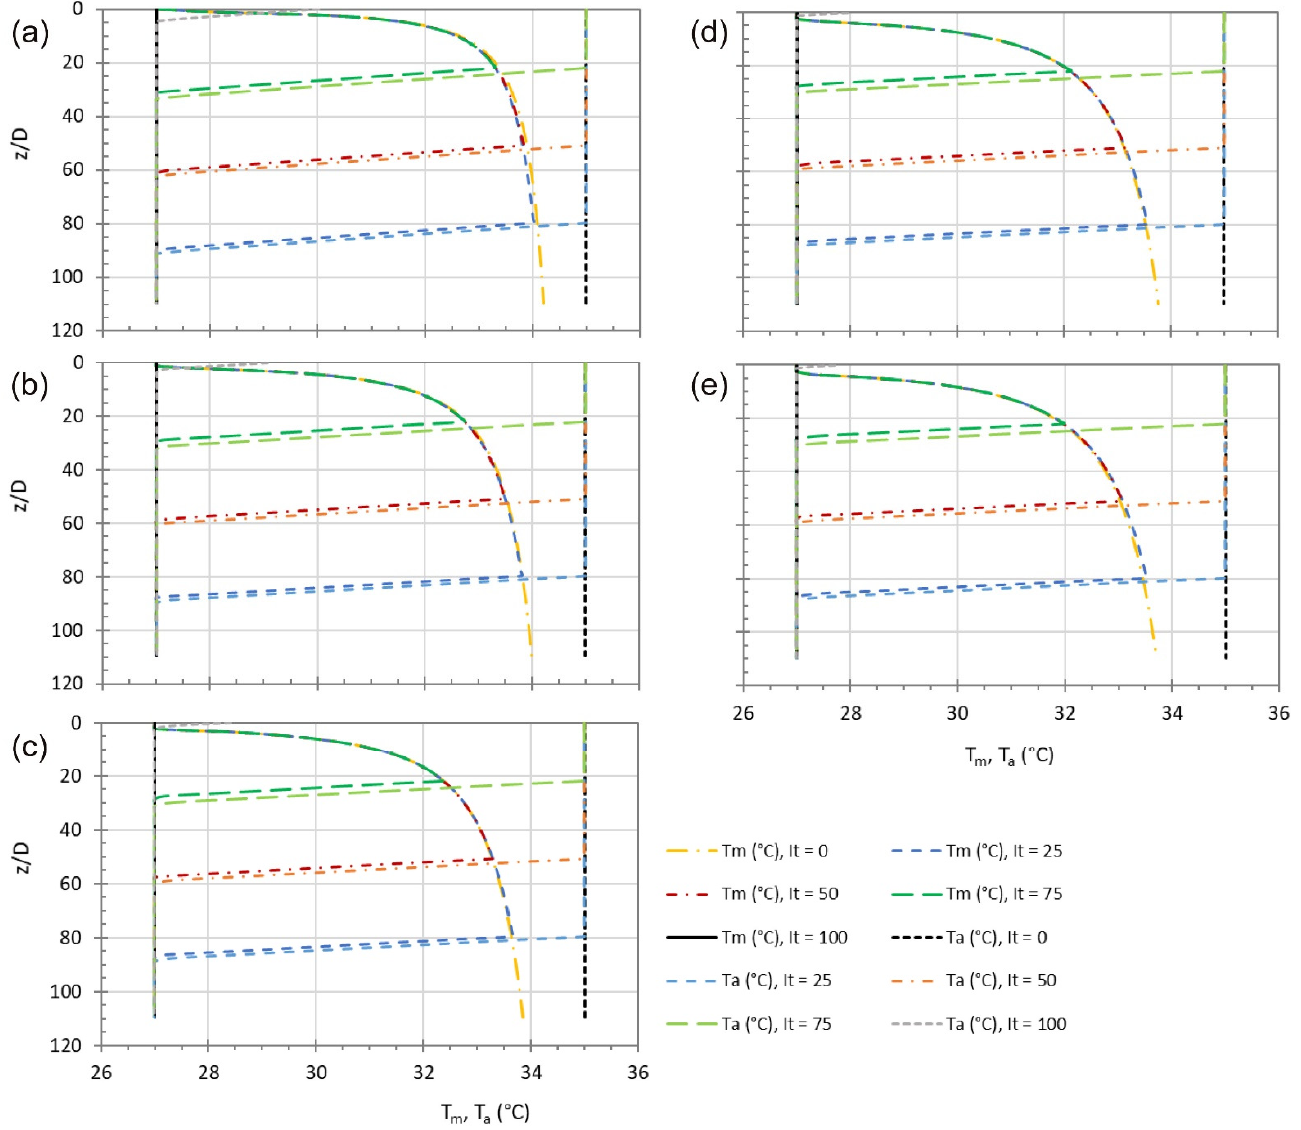
Figure 6. Variation of the air temperatures T m and T a ( ◦ C) with respect to the dimensionless vertical distance z / D from the exit of the air-conditioning device for the first cycle (it = 0) with uniform room air temperatures at 35 ◦ C, the cycle after 25 cycle calculations (it = 25) and the cycles after 50, 75 and 100 cycle calculations for: ( a ) θ 0 = 15 ◦ ; ( b ) θ 0 = 30 ◦ ; ( c ) θ 0 = 45 ◦ ; ( d ) θ 0 = 60 ◦ ; and ( e ) θ 0 = 75 ◦ . T m is the mean air temperature at the buoyant jet cross-section; and T a is the mean room air temperature outside the jet at the same level with T m . T m starts from T 0 = 27 ◦ C and T a from T a 0 = 35 ◦ C. T m and T a are shown with the same colours and line modes for the same cycle, but the colour for T a is a little lighter than that for T m